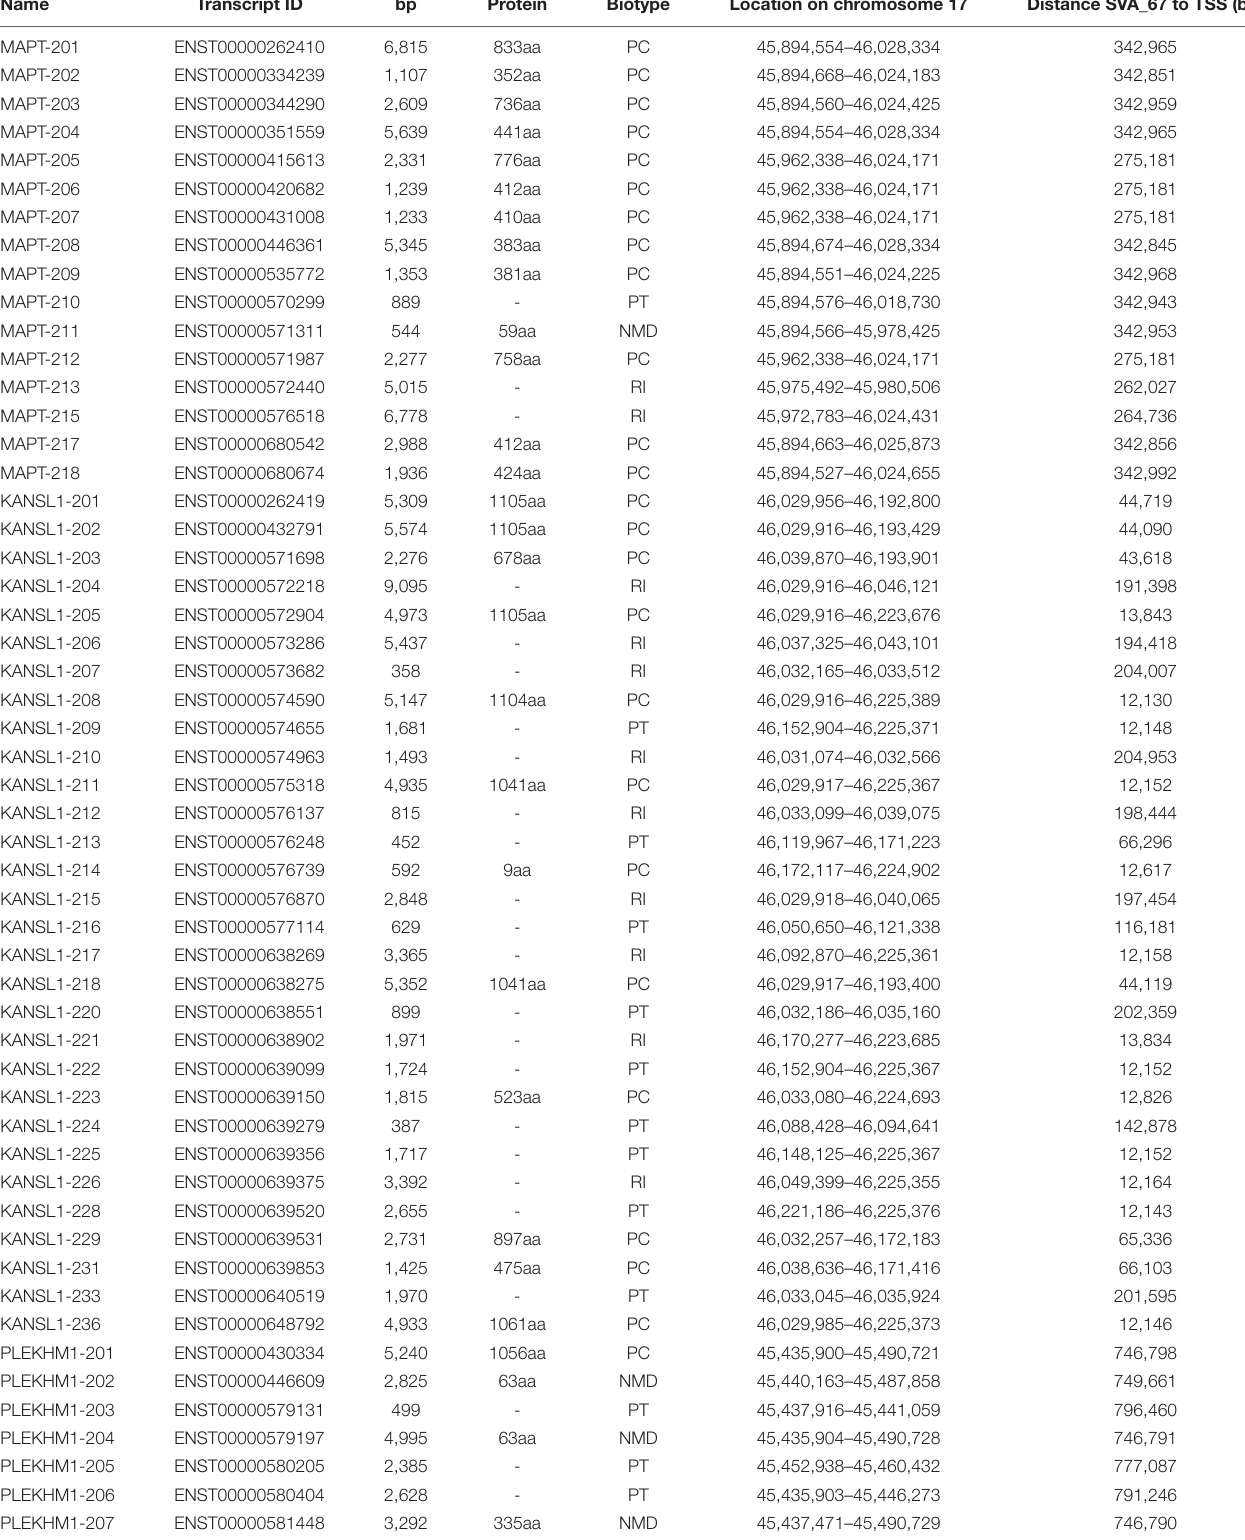
TABLE 1 | Analysed gene isoforms in this study and their